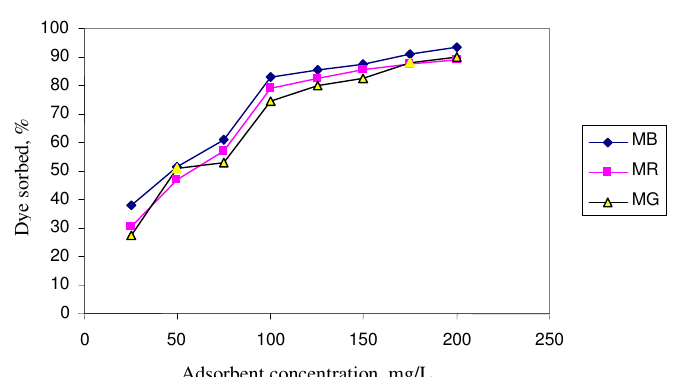
Figure 2. Influence of dye concentration on biosorption of MB, MR, and MG by the mixtures of leafs, fruits and twigs of Muntangia calibura (sorbent dose: 200 mg/50 mL; contact time: 3 h; pH: 6.0).